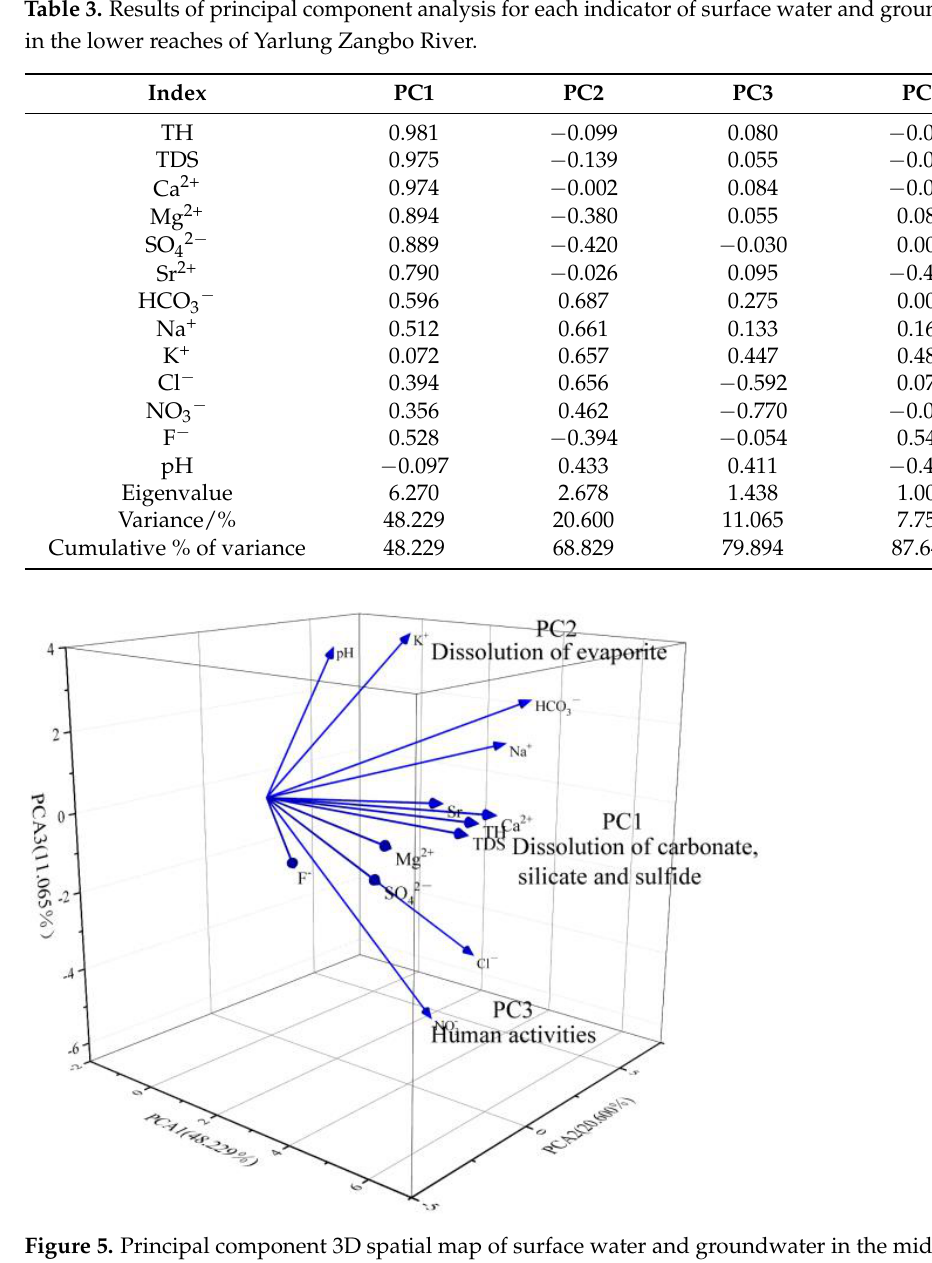
Figure 5. Principal component 3D spatial map of surface water and groundwater in the middle and lower reaches of Yarlung Zangbo River. Data are from Table lower reaches of Yarlung Zangbo River. Data are from Table 1.